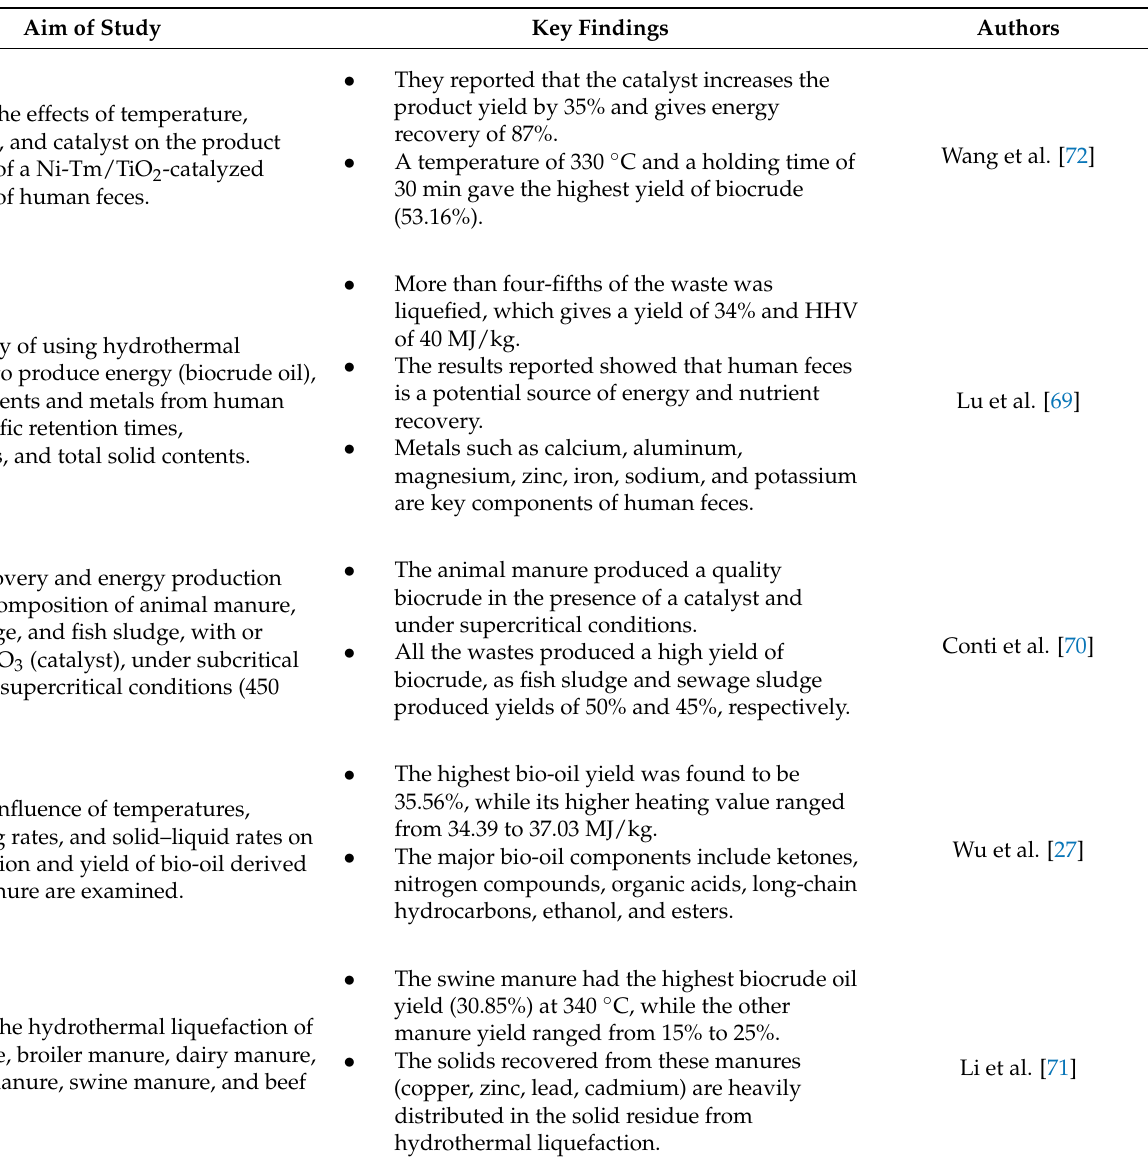
Table 6. Summary of past studies on the gasification of human and livestock